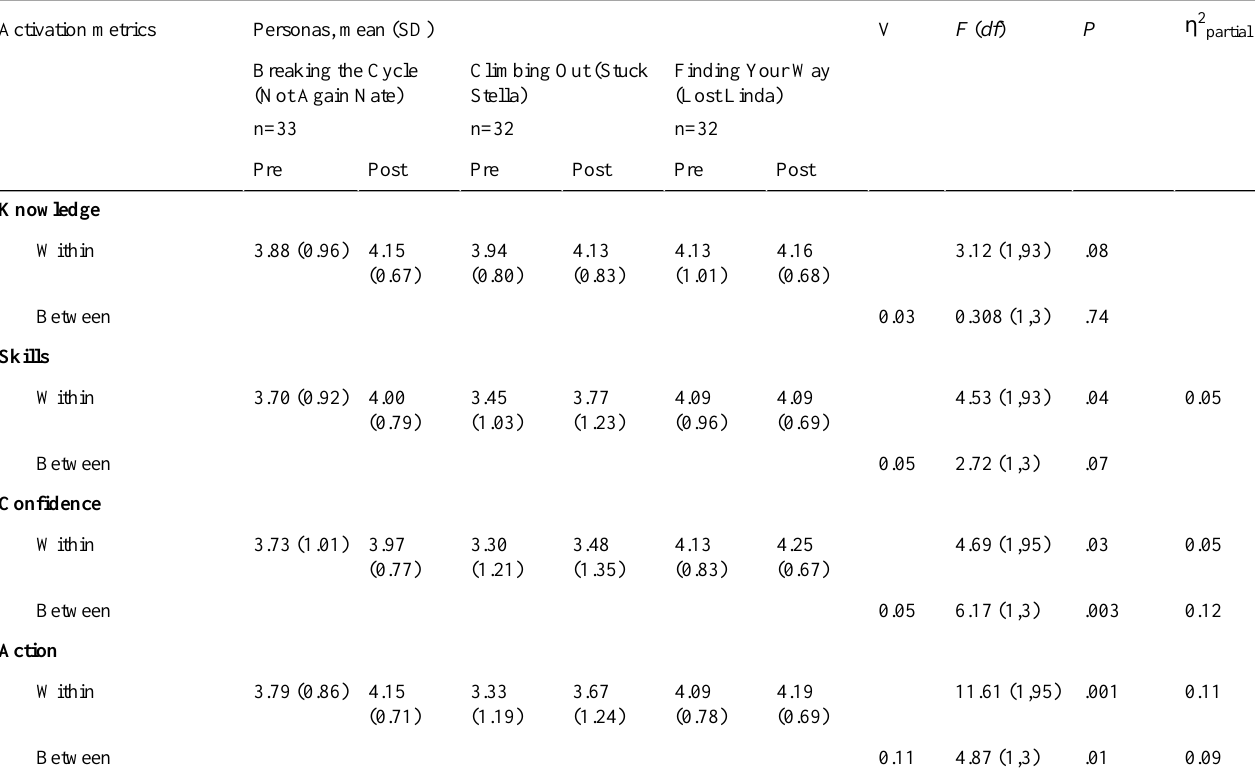
Table 5. Results of general linear model with repeated measures analyses of chronic health disease personas: depression.